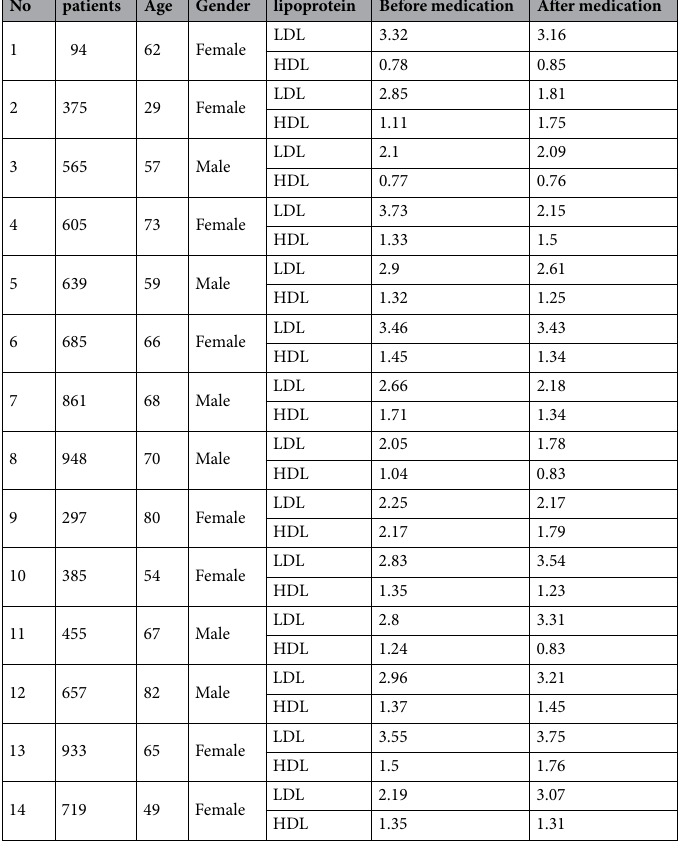
Table 2. The lipoprotein levels before and after